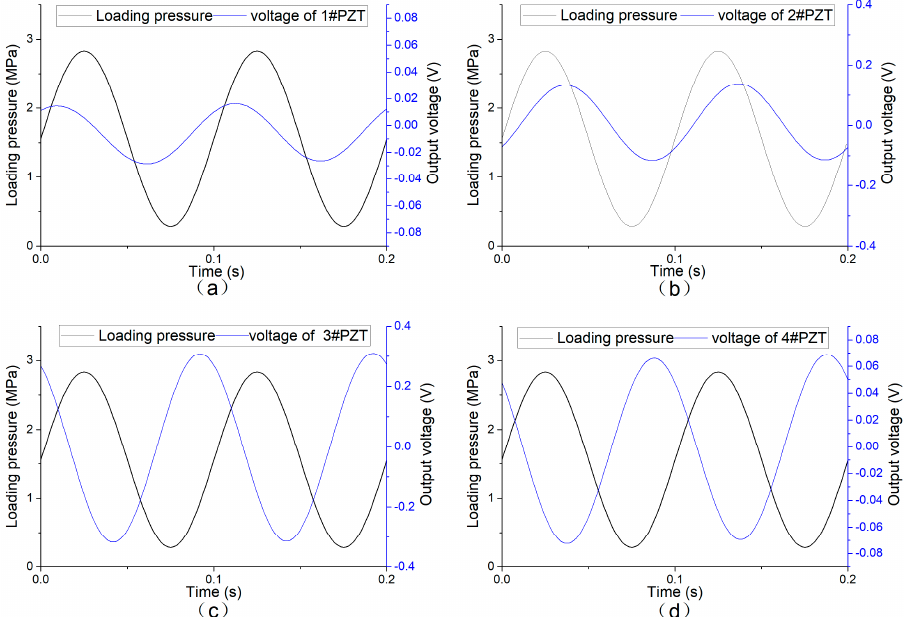
Figure 14. Output voltage of each channel of the system when loading frequency 10 Hz loading amplitude 10 kN. ( a ) 1#PZT output signal; ( b ) 2#PZT output signal; ( c ) 3#PZT output signal; ( d ) 4#PZT output signal.